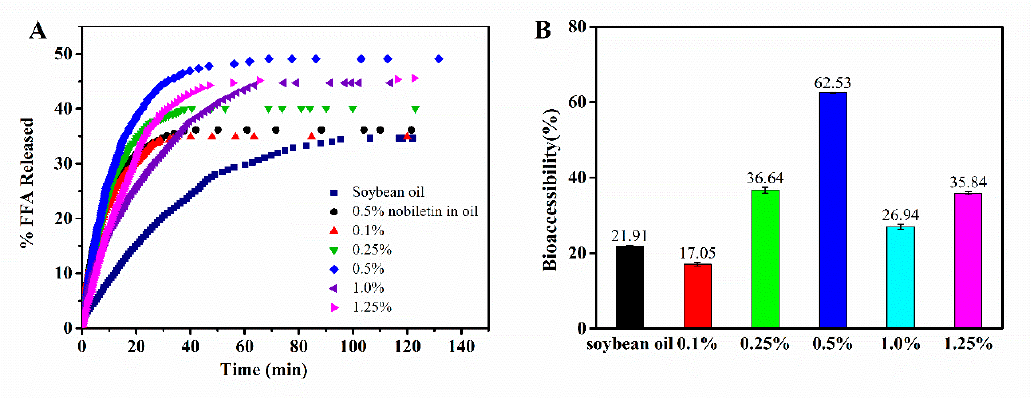
Figure 8. In vitro digestion of Pickering emulsion ( A ) Release profile of free fatty acids ( FFA ) and ( B ) bioaccessibility of nobiletin in soybean oil and Pickering emulsion stabilized by WPI fibrils after in vitro digestion.